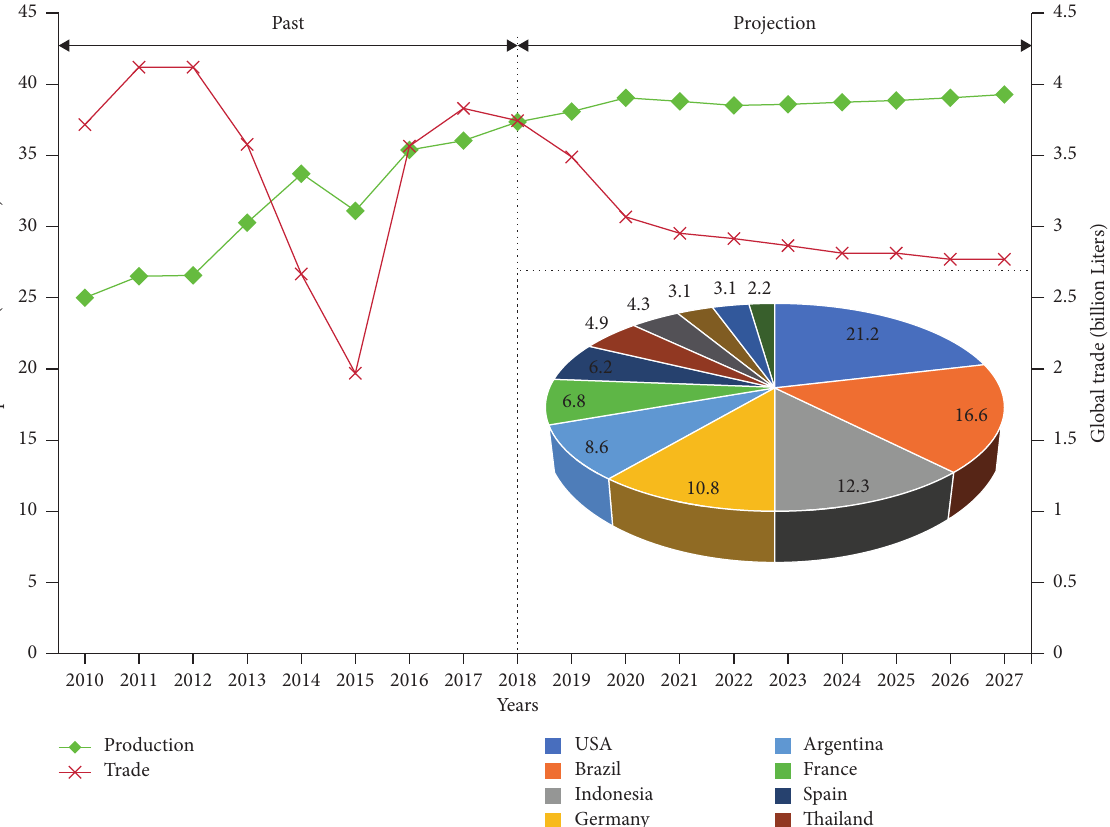
Figure 4: Market conditions and biodiesel production in several countries